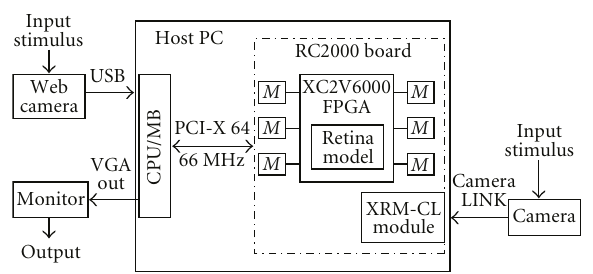
Figure 6: Test environment for RC2000 prototyping board.